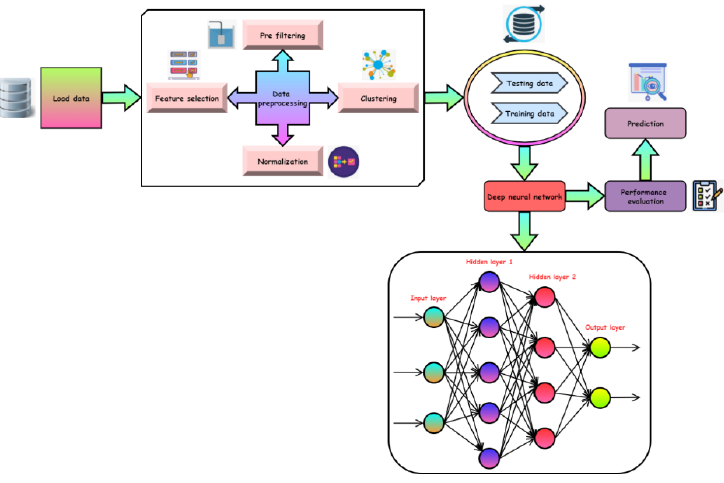
Figure 4. Deep neural networks-based energy sector for a sustainable economy.